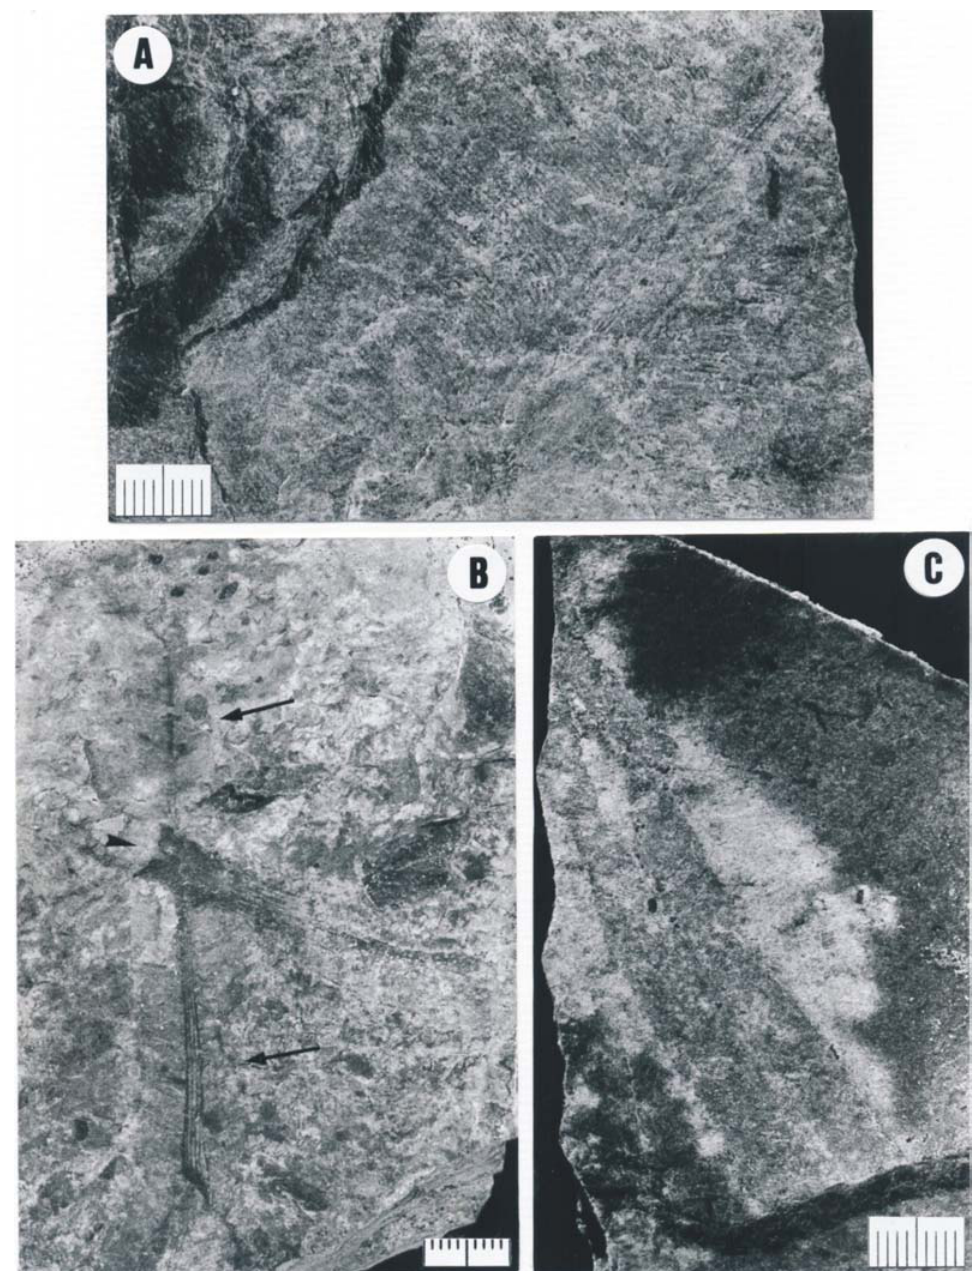
Fig. 2 – Photos of Glossopteris leaves: (A) Glossopteris cf. G. occidentalis White [MP-Pb 3576A] showing a middle portion of the leaf; (B) specimens of Glossopteris sp. 1 showing almost a complete leaf [MP-Pb 3577A – two longest arrows] and base of the leaf [MP-Pb 3577B – shortened arrow]; (C) Glossopteris sp. 1 showing the middle part and top of the leaf [MP-Pb 3585A]. Scale bars: 1.0 cm.